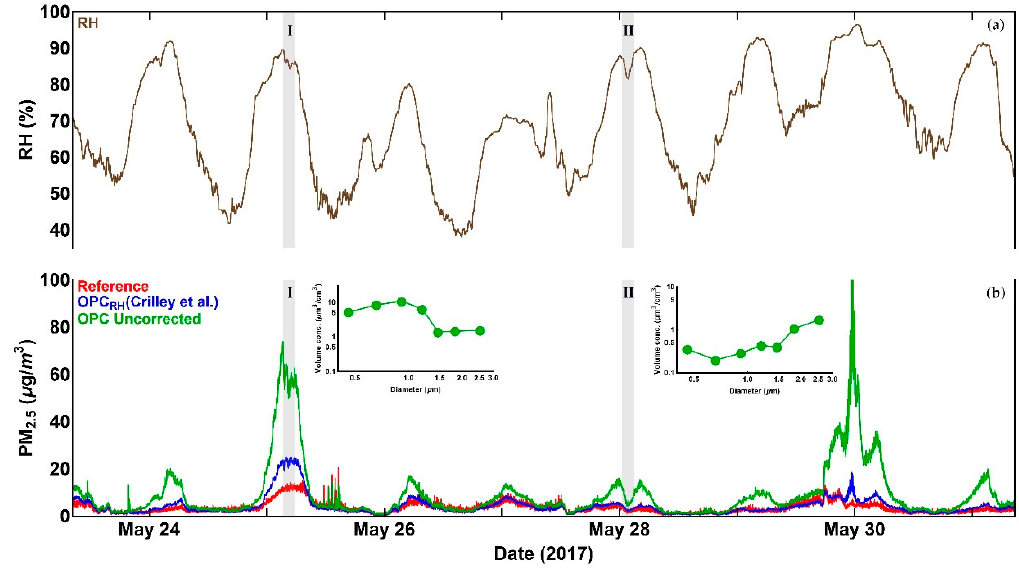
Figure 1. Time series of Alphasense OPC-N2 PM 2.5 measurements compared with reference data: ( a ) Time series of relative humidity; ( b ) Time series of Alphasense OPC-N2 PM 2.5 measurements, before and after the application of the Crilley et al. correction factor, in comparison with reference data. The two inserts show volume distribution profiles measured by the uncorrected OPC-N2 for periods I and II. The overall measurement period consists of seven consecutive days data between 23 May and 31 May 2017. See text for discussion. (PM: particulate matter).